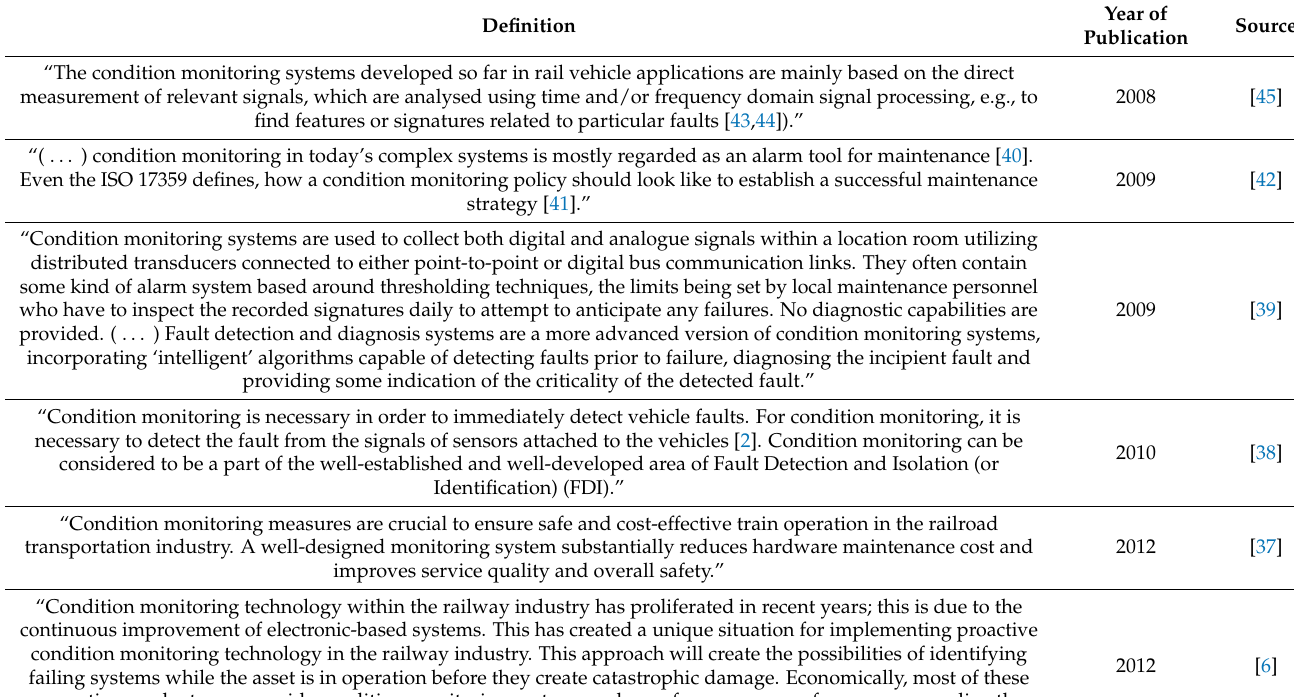
Table 1. The overview of definitions and approaches connected to the condition monitoring of rail transport systems. Source: own elaboration based on references directly mentioned in the